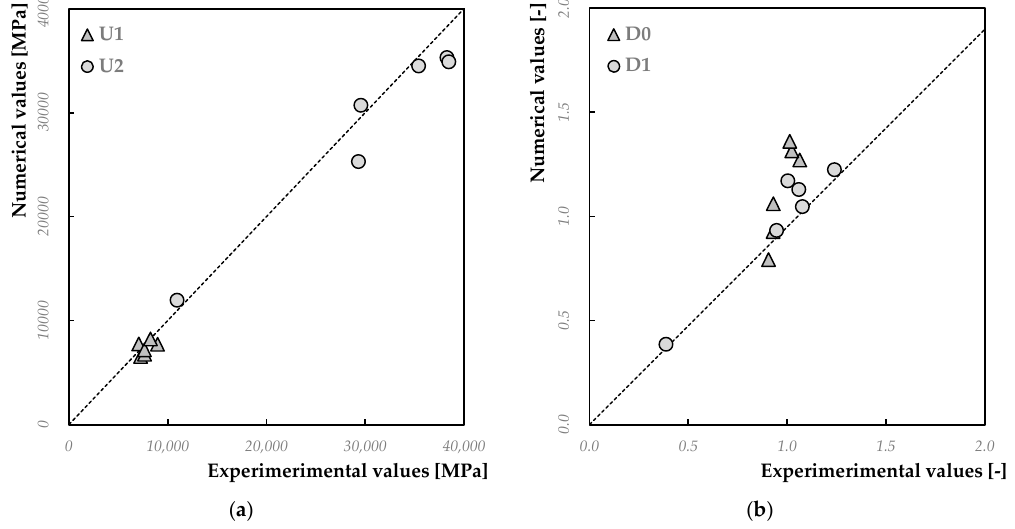
Figure 8. Numerical versus experimental data for ( a ) work capacity indices and ( b ) ductility